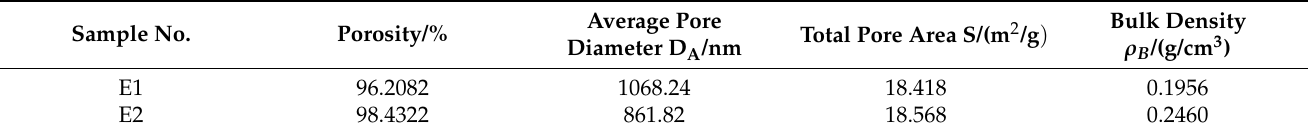
Table 4. MIP test results.